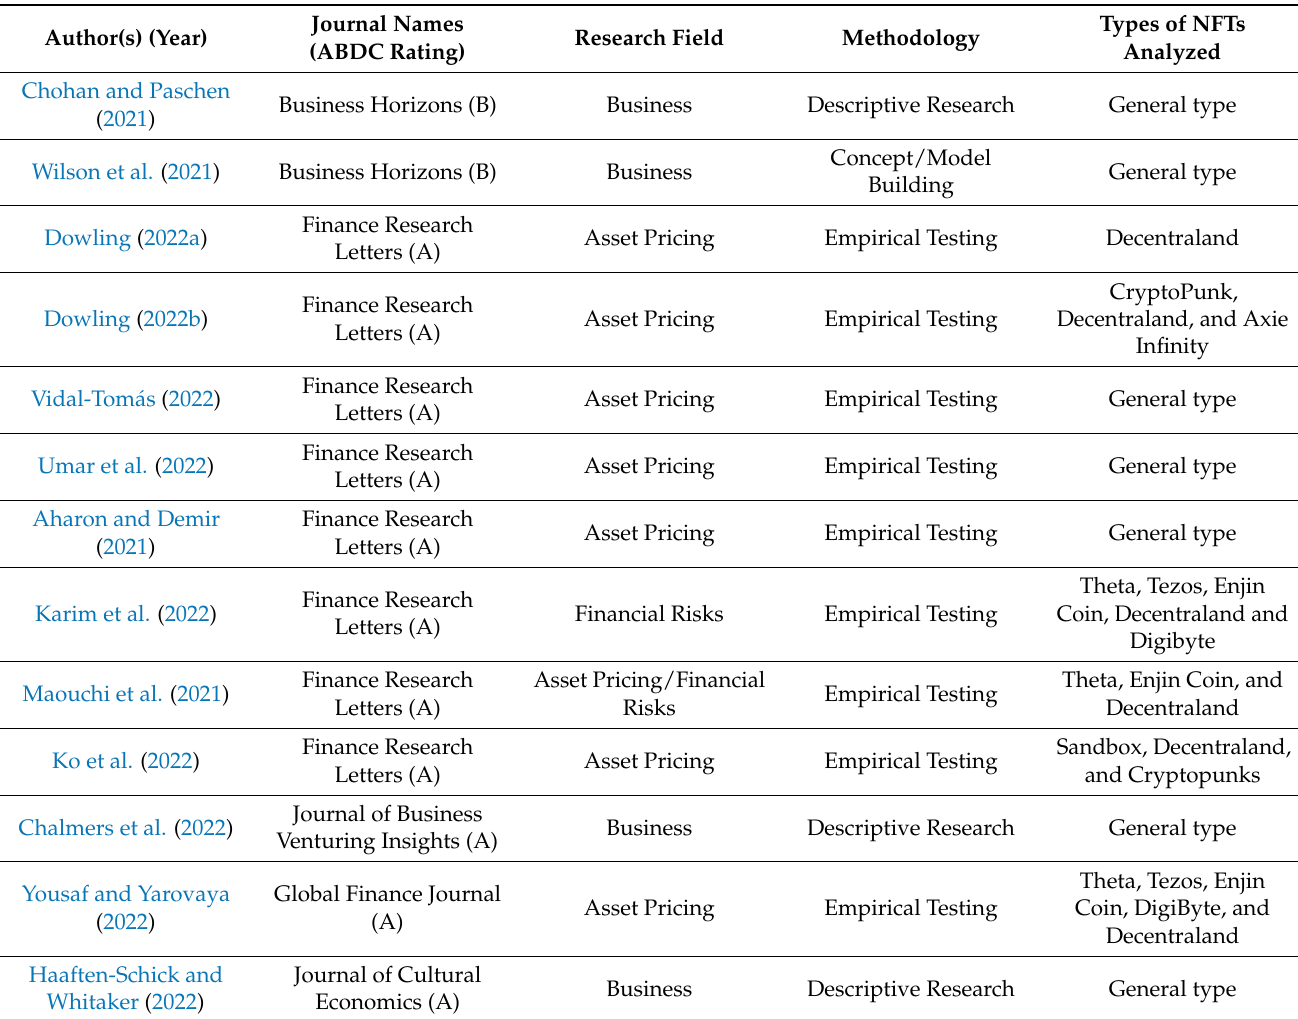
Table 1. Summary of the identified